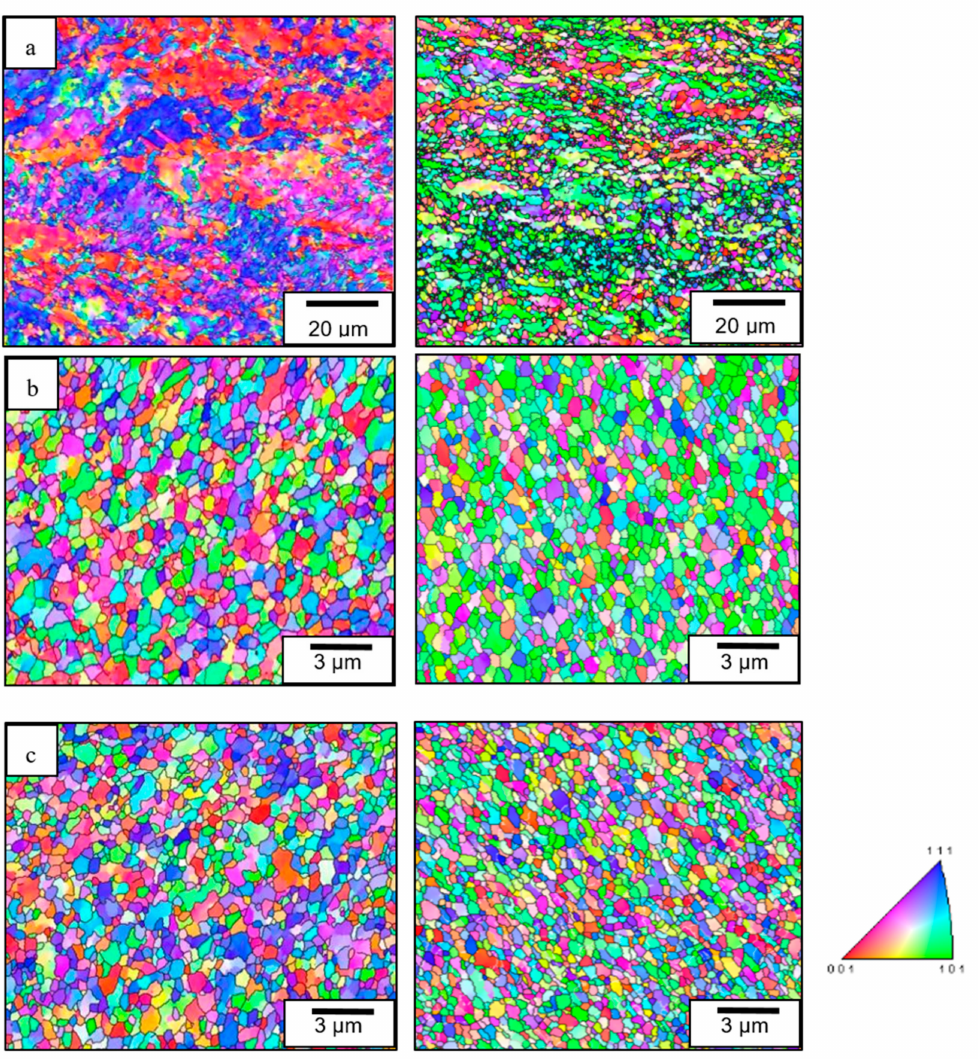
Figure 3. OIM maps from ( left ) transverse and ( right ) longitude sections of the sample areas at ( a ) the center; ( b ) the mid-radius; and ( c ) the edge, after